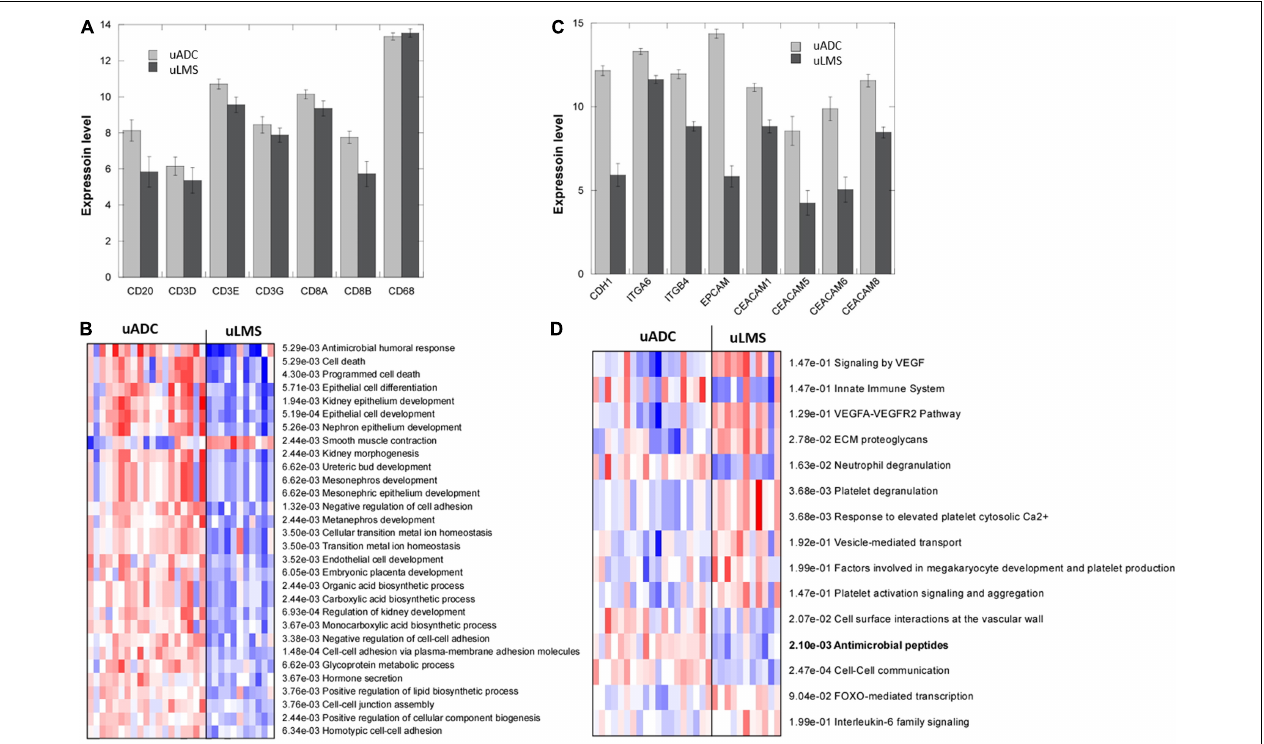
FIGURE 5 | Transcriptomic profiling of invasive tumor front (ITF) in uterine adenocarcinomas (uADC) and leiomyosarcomas (uLMS). (A) RNA-seq expression levels (as counts per million, log2 scale) of cellular markers for macrophages (CD68), T cells (CD3 and CD8), and B lymphocytes (CD20). Slight upregulation of B and T cell markers is observed. (B) Parametric analysis of gene-set enrichment using the Gene Ontology biological process dataset. Red and blue indicate activated and suppressed pathways, respectively. (C) RNA-seq expression levels (as counts per million, log2 scale) of genes related to cell adhesion and epithelial cell development. Increased gene expression in uADC vs. uLMS was significant in all the markers. (D) Parametric analysis of gene-set enrichment using the curated reactome dataset reveals a possible role for antimicrobial peptides in immune response of uADC. Red and blue indicate activated and suppressed pathways,